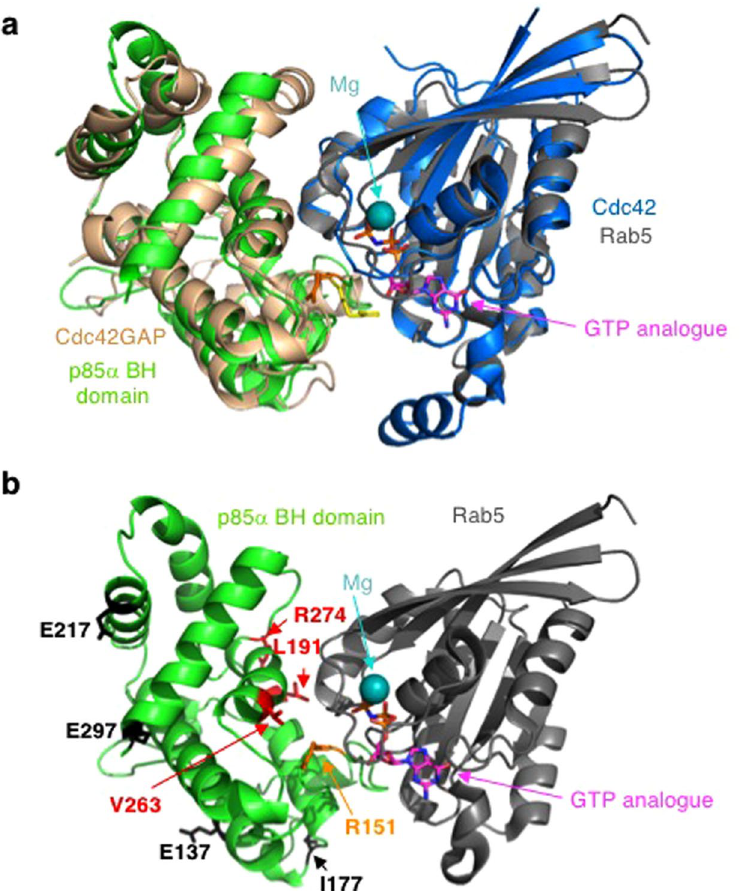
Figure 6. Modeled interface region between the human p85 α BH domain and Rab5. ( a ) Overlay of the crystal structure of human Cdc42GAP (tan) – Cdc42 (blue) complex (PDB ID: 2NGR) with the human p85 α BH domain (green; PDB ID: 1PBW) and the human Rab5-GTP analogue (15–184; grey; PDB ID: 1R2Q). The magnesium (teal) and GTP analogue (magenta) bound to Rab5 are indicated. Catalytically important arginine residues within Cdc42GAP (yellow) and p85 α BH domain (orange) are shown. ( b ) Modeled human p85 α BH domain (green) – Rab5 (grey) complex. The magnesium (teal) and GTP analogue (magenta) bound to Rab5 are indicated. Key p85 α BH domain residues are shown: R151 (orange, important for GAP activity), and residues in red are important for Rab5 binding (L191, V263, R274). The location of patient-derived p85 α BH mutations with significant impacts on Rab5 binding are shown in black (E137, I177, E217,